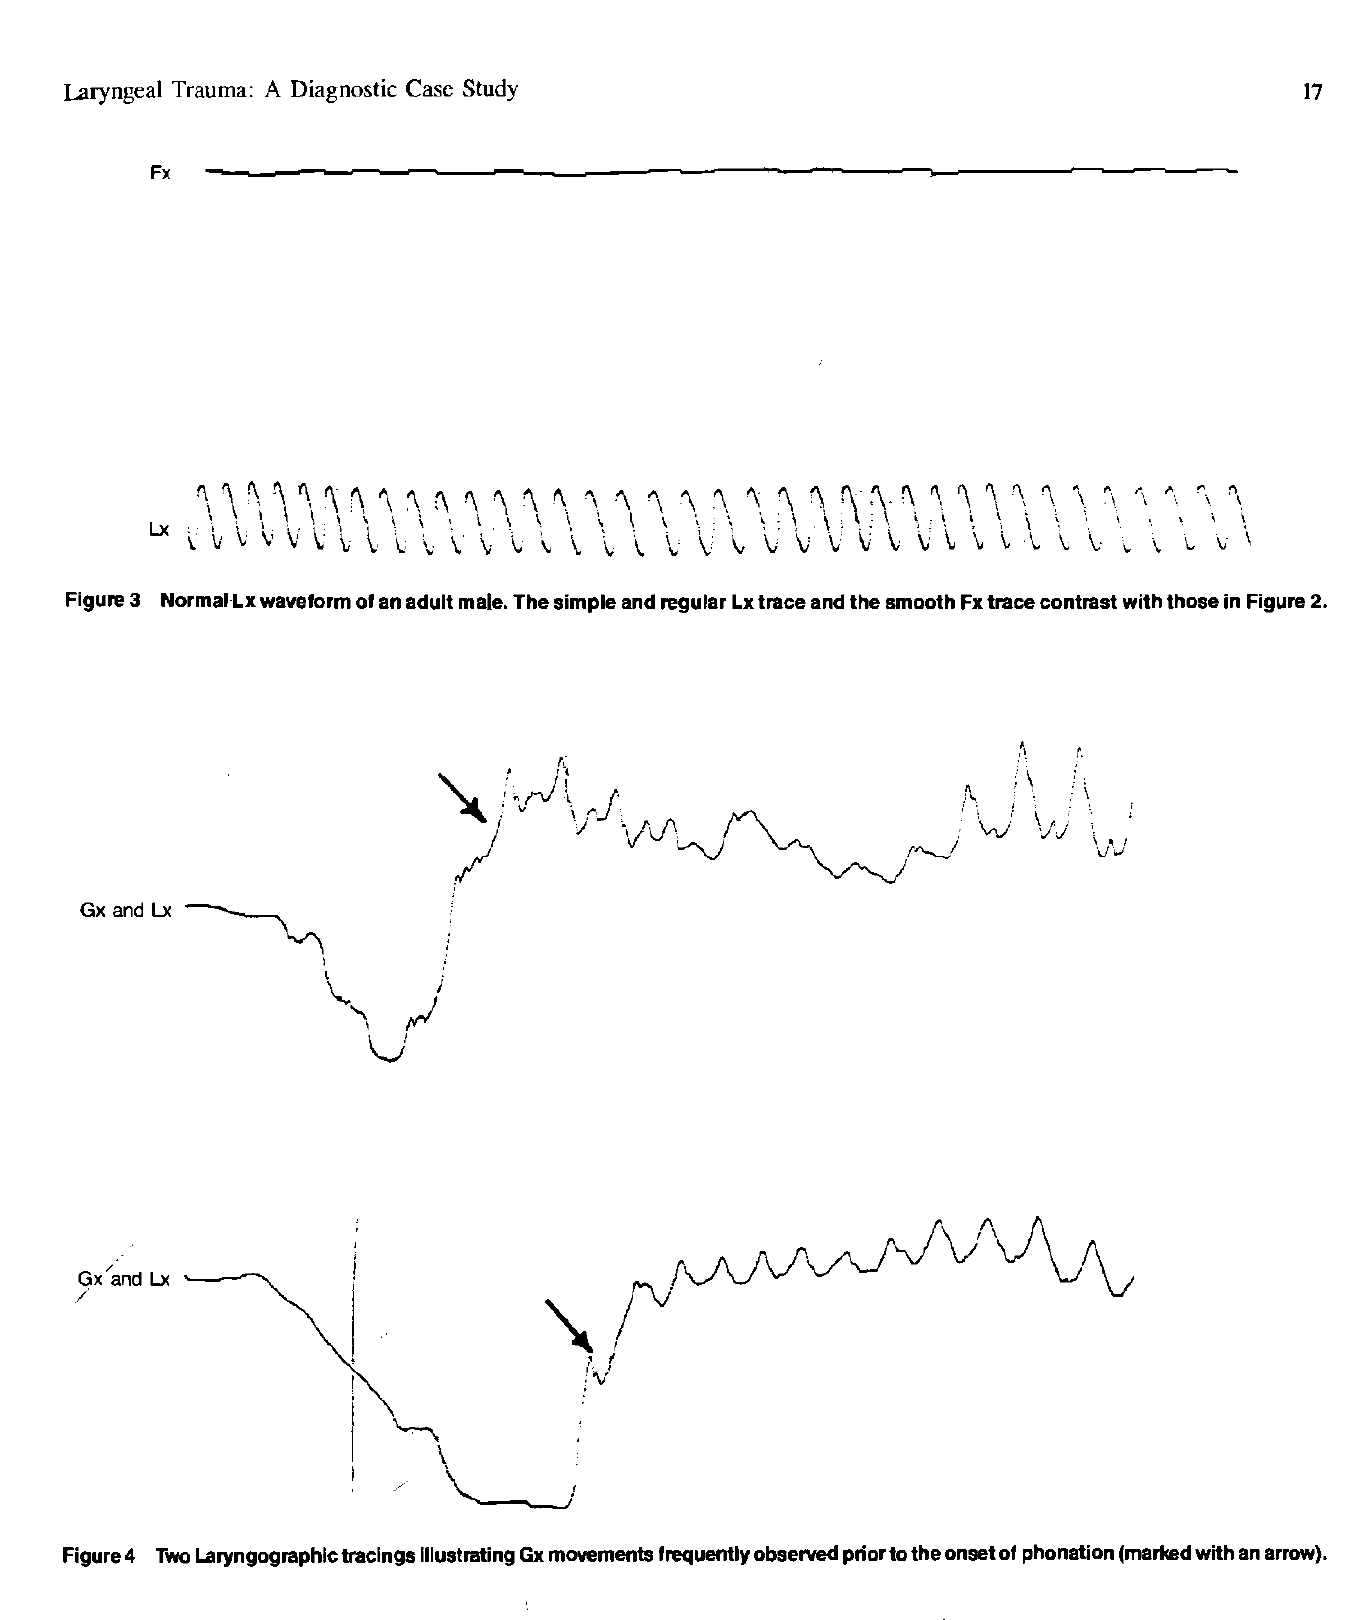
Figure 4 Two Laryngographic tracings illustrating Gx movements frequently observed prior to the onset of phonation (marked with an arrow).